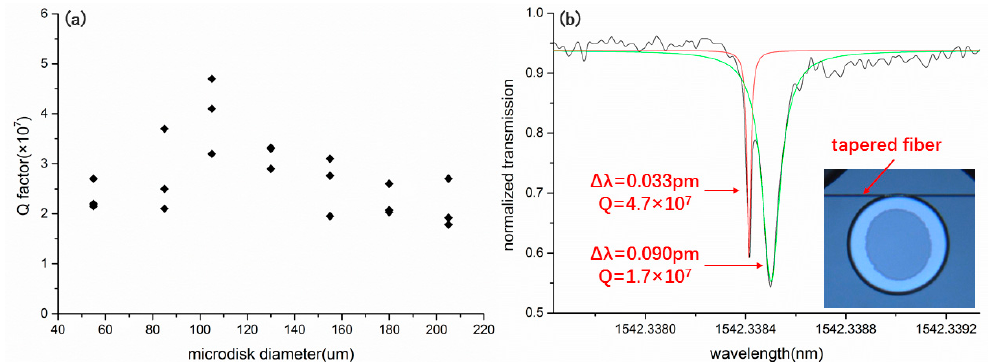
Figure 3. ( a ) Measured Q factors of the mcirodisks of different diameters. ( b ) The Lorentz fitting (red curve) of a splitting mode in the microdisk with a diameter of 105 μ m revealed a Q factor of 4.7 × 10 7 .